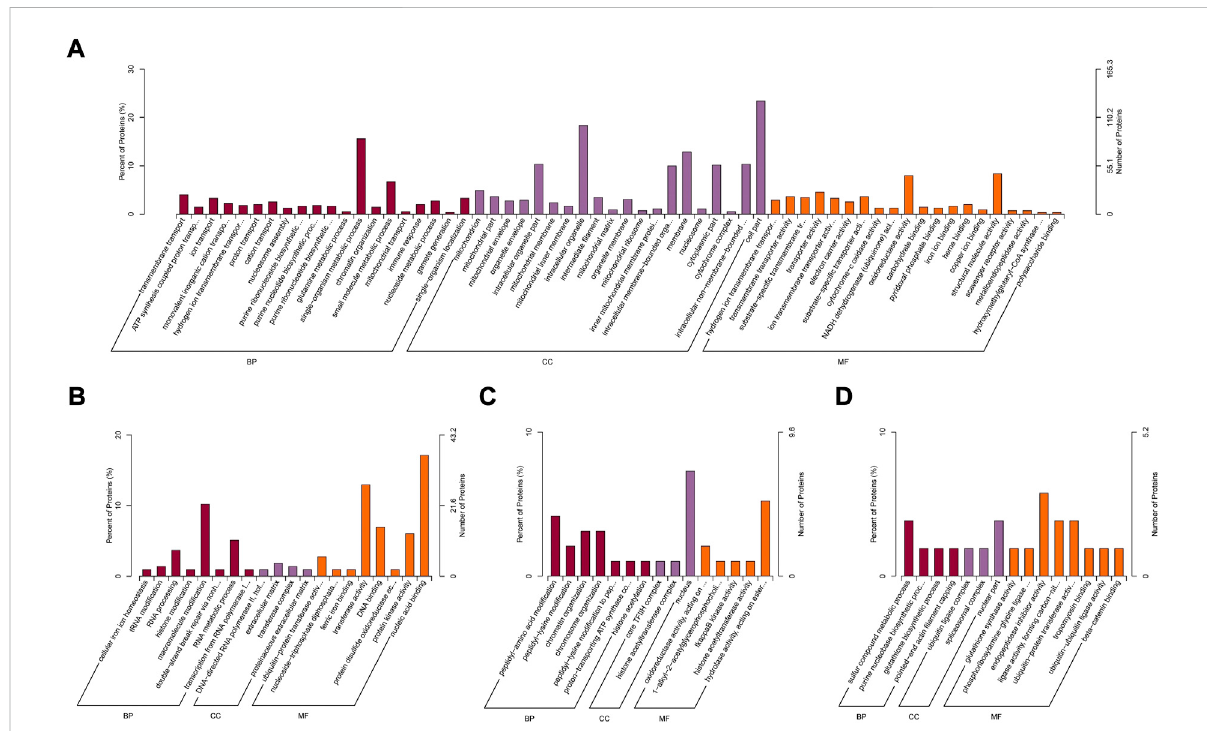
FIGURE 5 GO enrichment analysis of differentially abundant proteins in rumen epithelium between (A) day 0 and day 15, (B) day 15 and day 30, (C) day 30 and day 45 and (D) day 45 and day 60 of age. All pathways are listed according to p